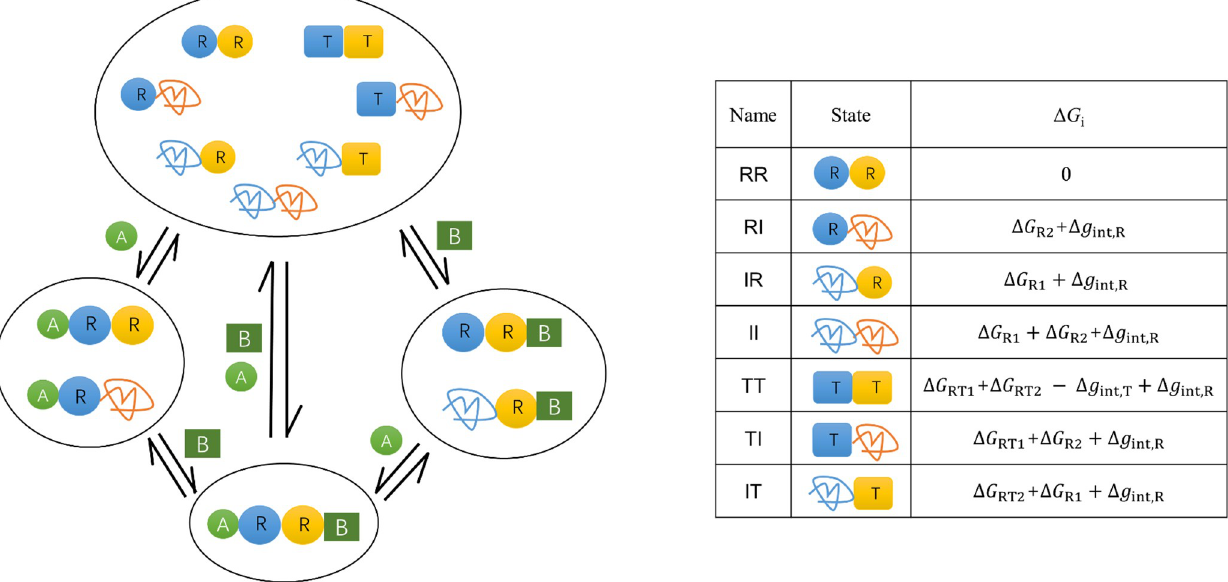
PLOS Computational Biology | https://doi.org/10.1371/journal.pcbi.1006393 December 3,